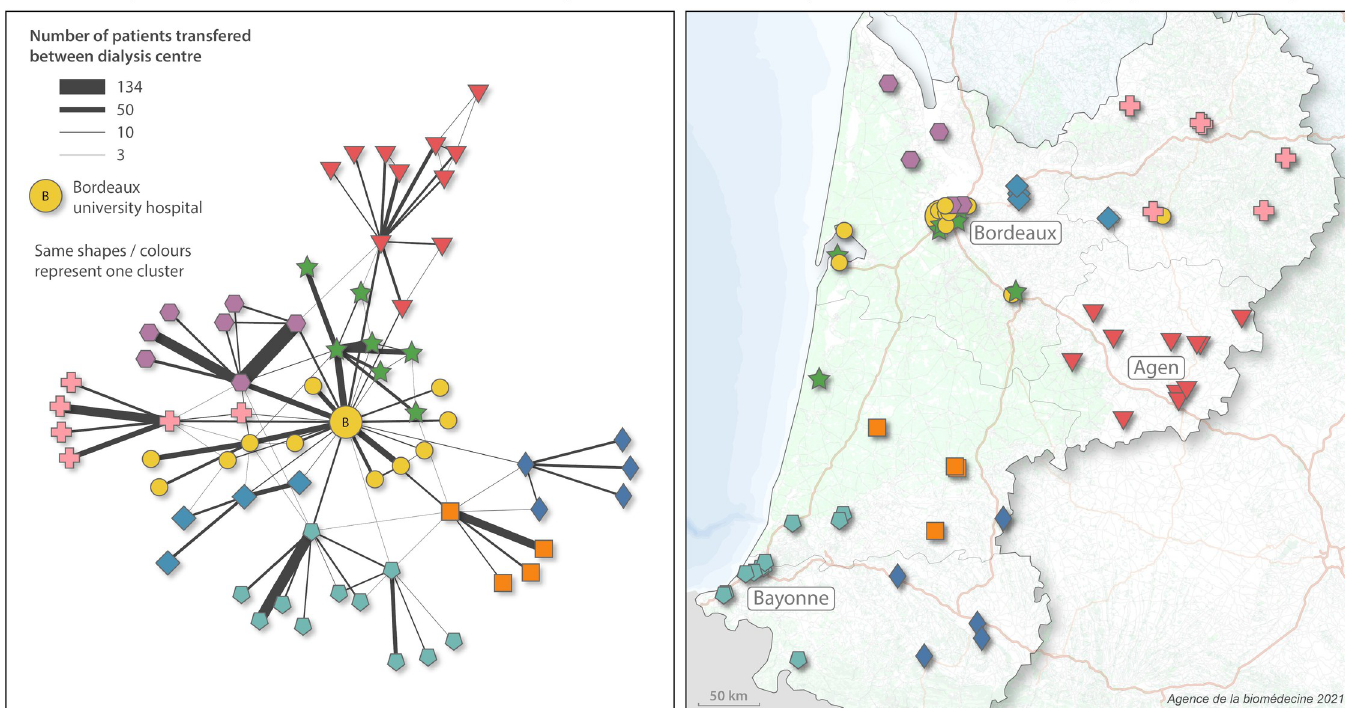
Fig 2. Results of the Fast Greedy clustering in the Aquitaine region. The basemap was built from OpenStreetMap open data.: https://www.openstreetmap.org/copyright.